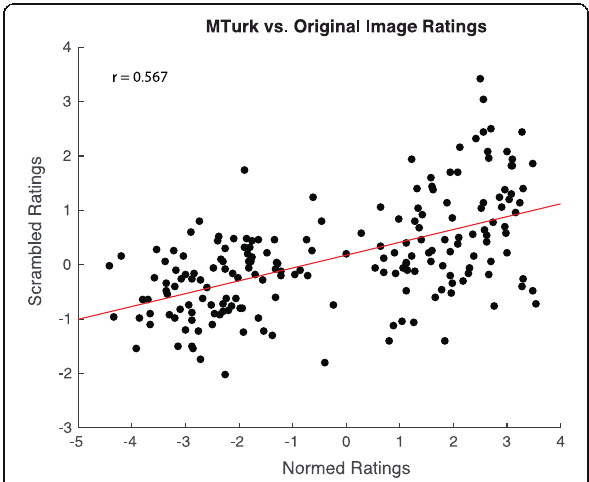
Fig. 5 Correlation between the average ratings of the original images ( x-axis ) and the average ratings of the scrambled images ( y-axis